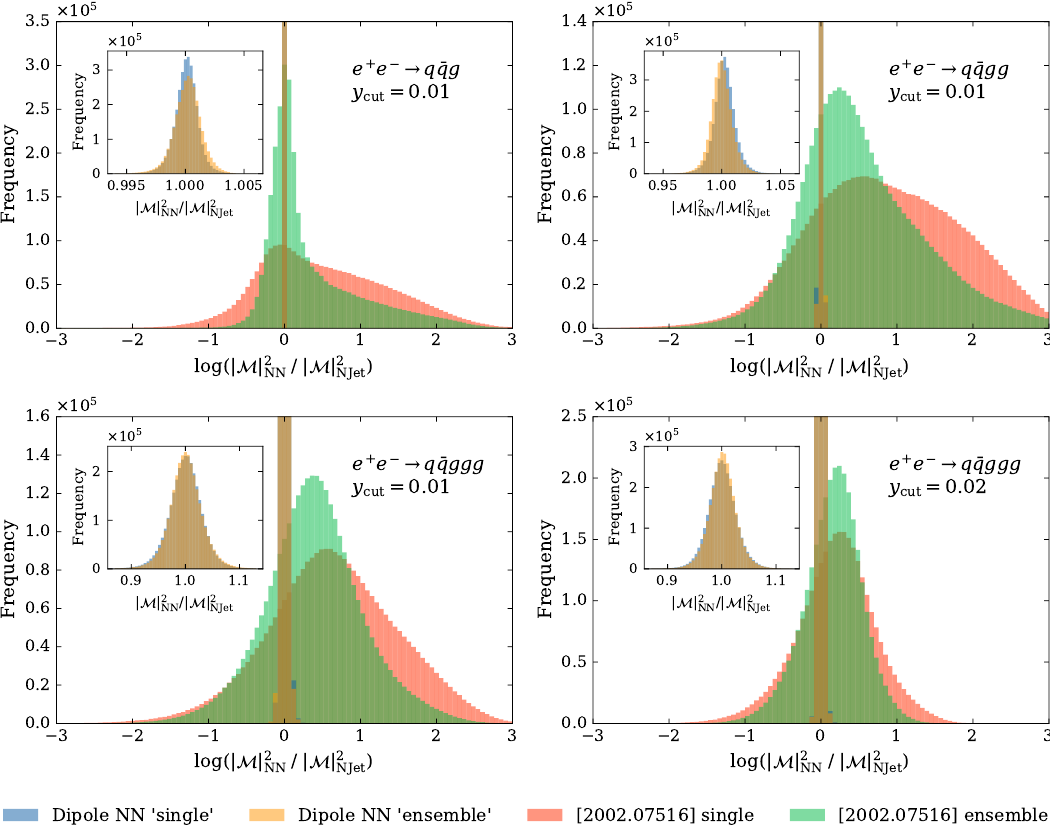
Figure 2 . Error distribution compared to figure 3 in ref. [27], where data to reproduce the his- tograms were provided by the authors. We plot the log ratio of the matrix element as predicted by the neural network ensemble and the value from NJet on the main axes for comparison. The blue and orange dipole histograms representing our method are cut off at the top on the main axes, but the most important feature is the narrowness of the peak centred around the ideal value. The insets show the detailed distribution of our result on a linear